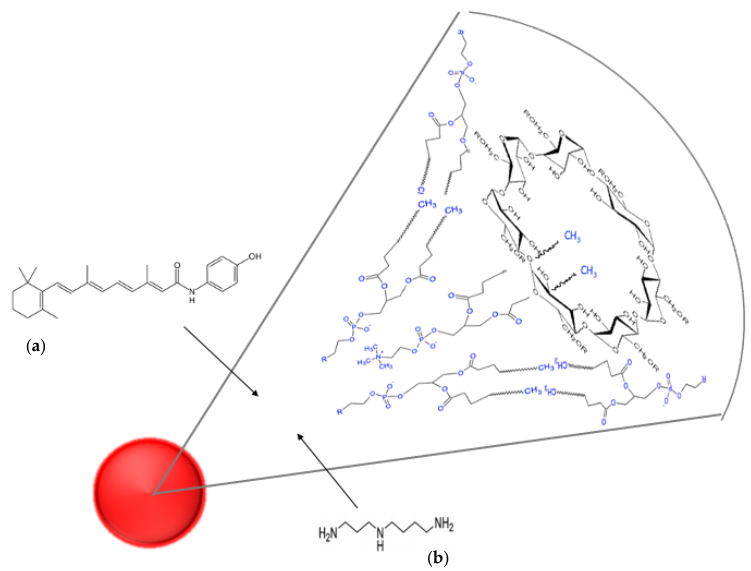
Figure 2. Schematic representation of the supramolecular organization of ( a ) Nanofenretinide and ( b ) Nanospermidine. Main constituents: fenretinide or spermidine, phospholipids and 2-hydroxypropyl beta cyclodextrin.